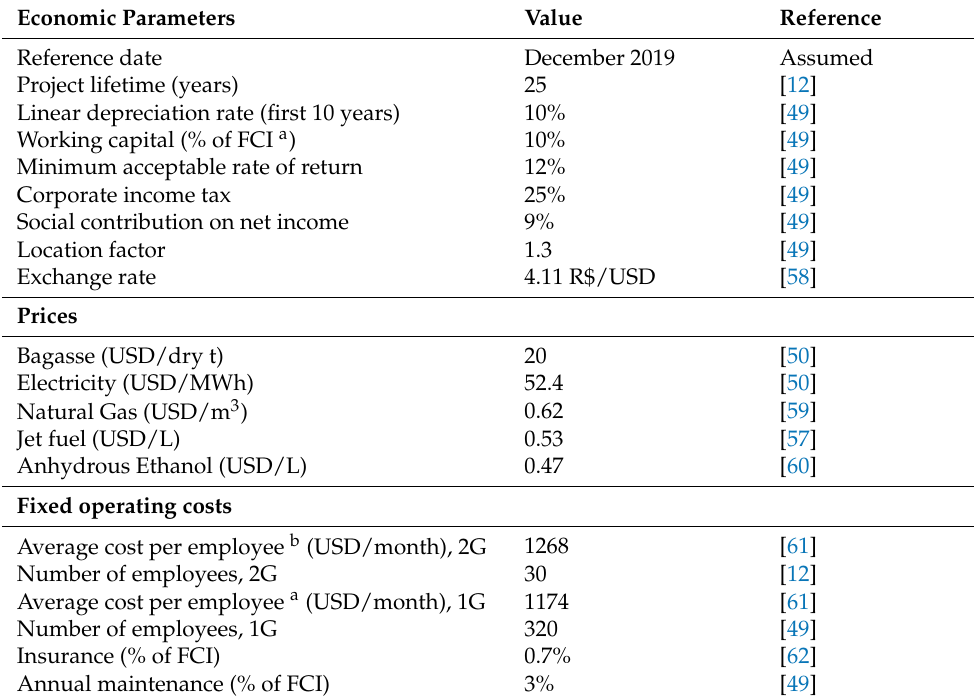
Table 3. Main parameters used in the techno-economic analysis of integrated and stand- alone